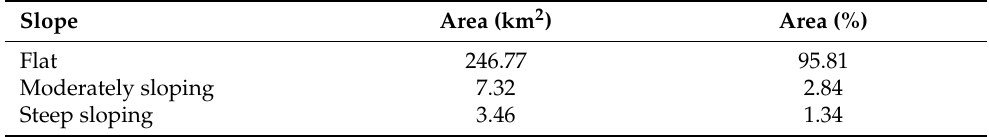
Table 8. Slope classes over the research area and their area expressed in km 2 and